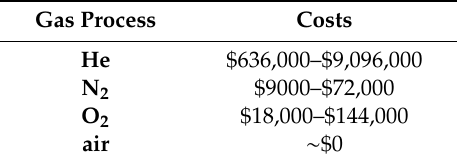
Table 5. NTP cost process as a function of di ff erent kinds of